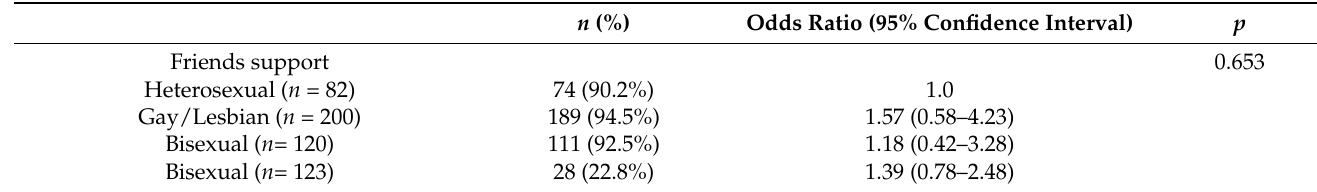
Table 4. Associations between sexual orientation and social